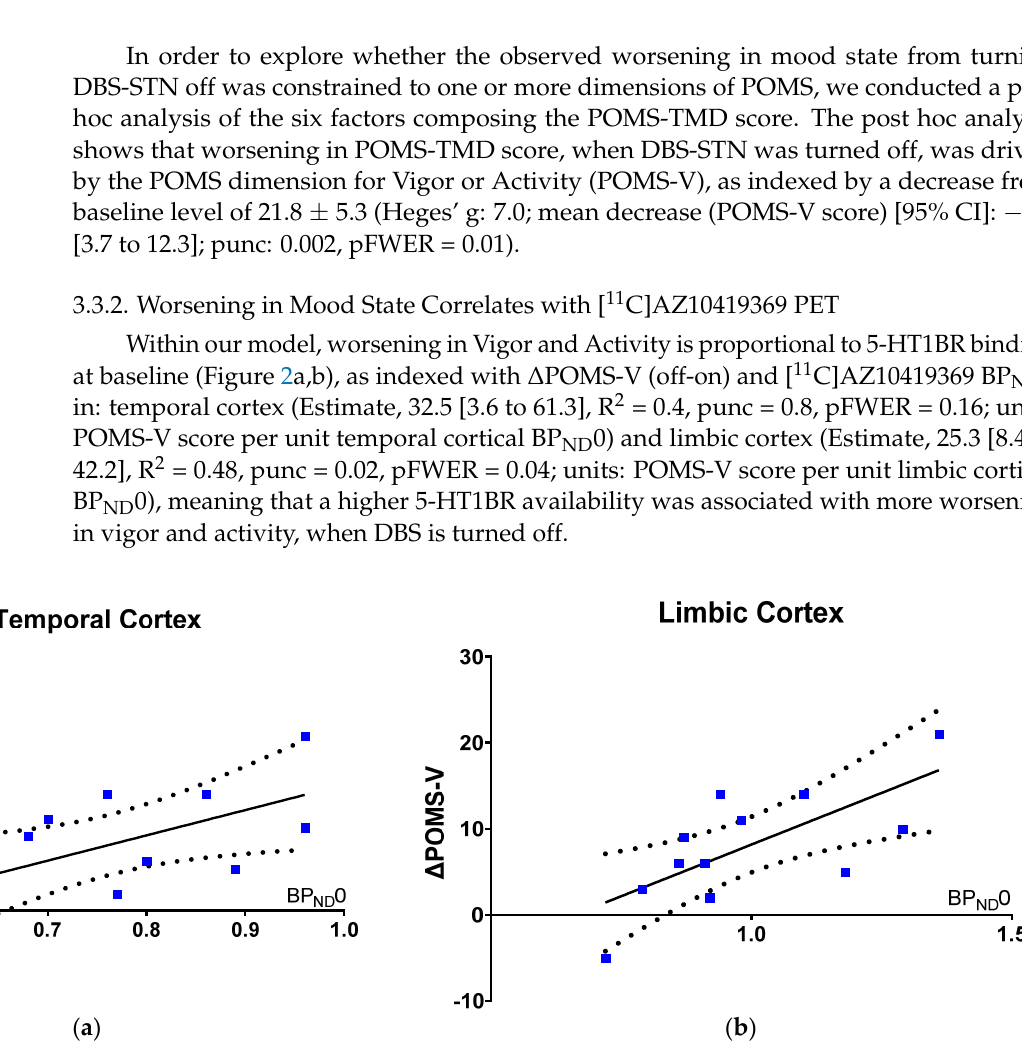
Figure 2. 5-HT1BR binding vs. worsening in mood with DBS turned off. The association between change in POMS V (off-on), when DBS is turned off in PD patients, and ( a ) temporal and ( b ) limbic [ 11 C]AZ10419369 BP ND 0.